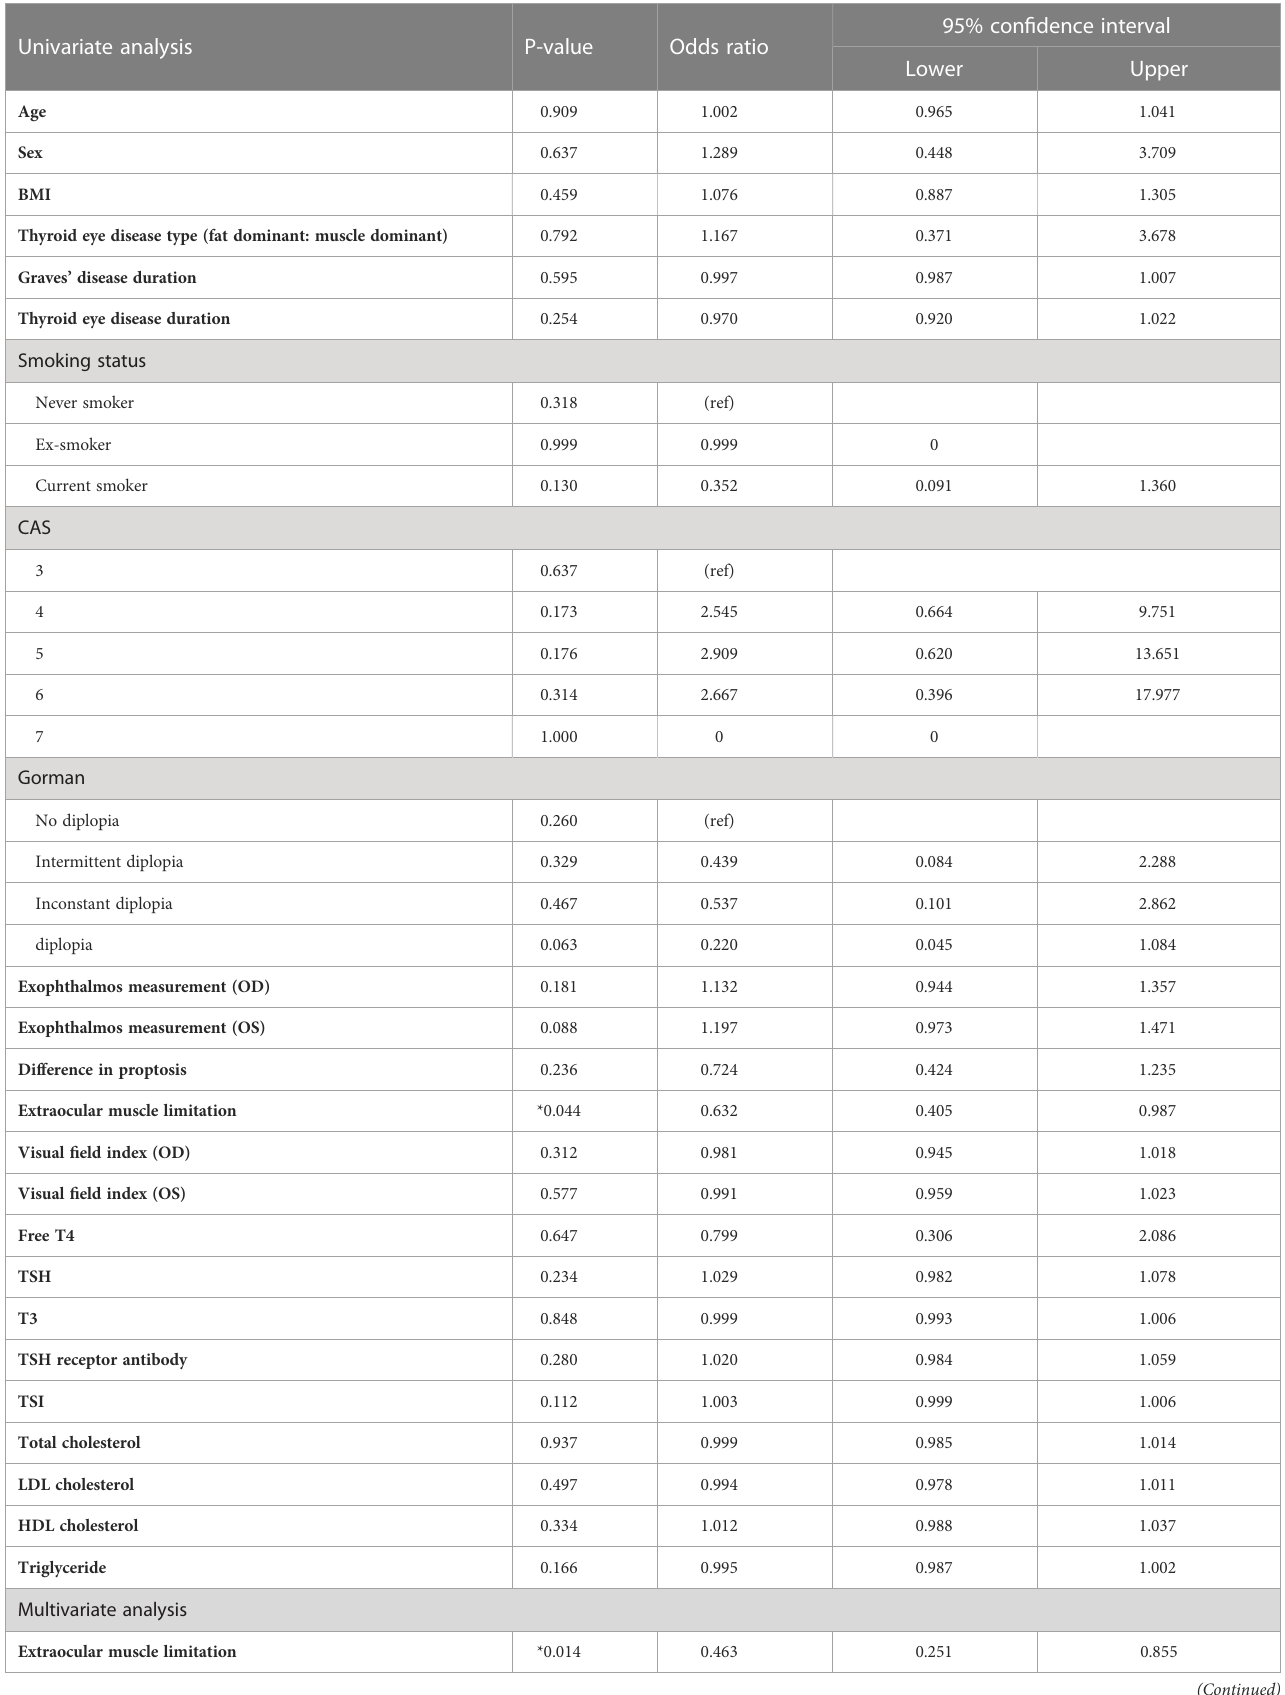
TABLE 2 Factors associated with the response to the steroid treatment investigated by univariate and multivariate binary logistic regression analysis (for an unresponsive